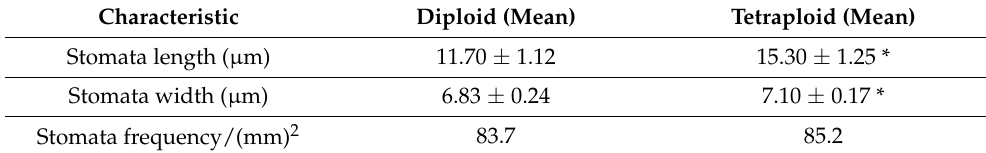
Table 2. Stomata characteristics in diploid and tetraploid Polemonium caeruleum.